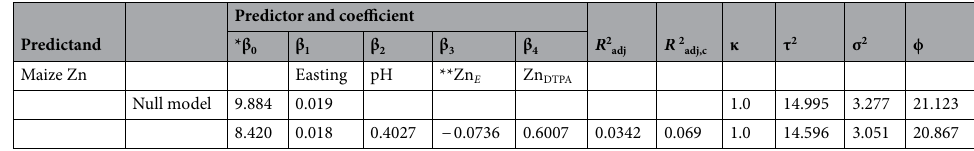
Table 4. Fitted models for soil properties and maize grain Zn concentration in Malawi. *β 0 –β 4 , fixed effects coefficients β 0 is a constant and β i is the coefficient for the i th random effect; R 2 adj , the difference between the sum of the variances of the random effects for the null model and the proposed model expressed as a proportion of the sum for the null model; R 2 adj,c , the difference between the variance of the correlated random effect (σ 22 ,variance of the iid random effect (nugget variance); σ 2 , variance of the correlated random effect; ϕ, distance parameter of the Matérn correlation function. **The subscripts E and DTPA denote the isotopically exchangeable (isotopic dilution), and potentially available (DTPA extractable) fraction, respectively.